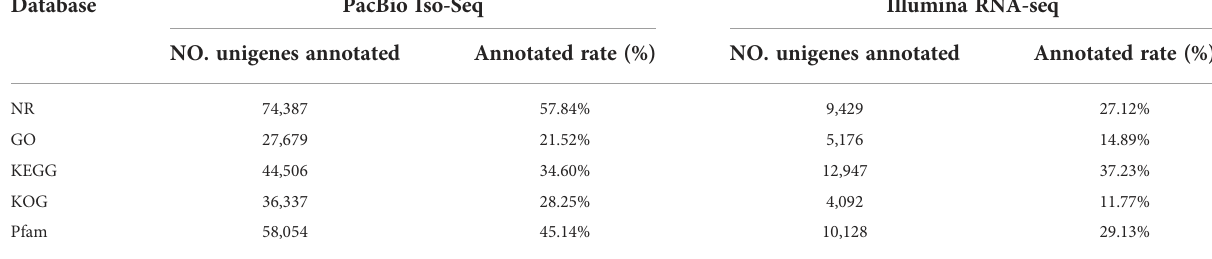
TABLE 4 Statistics of unigenes annotation with different databases.